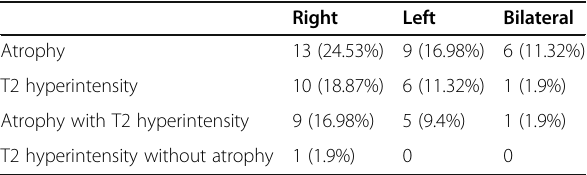
Table 2 Hippocampal atrophy and T2 hyperintensity distribution in CPS (focal onset seizures with impaired awareness) Right Left Bilateral Atrophy 13 (24.53%) 9 (16.98%) 6 (11.32%) T2 hyperintensity 10 (18.87%) 6 (11.32%) 1 (1.9%) Atrophy with T2 hyperintensity 9 (16.98%) 5 (9.4%) 1 (1.9%) T2 hyperintensity without atrophy 1 (1.9%) 0 0